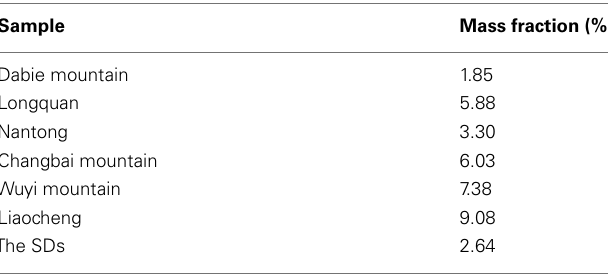
Table 5 |Triterpenoid content of Ganoderma lucidum in different